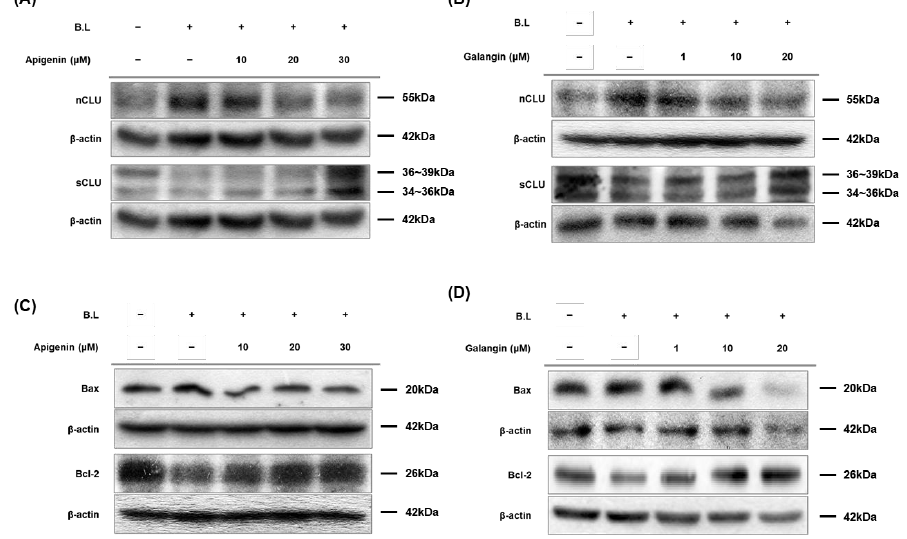
Figure 6. Apigenin and galangin regulated expression of nuclear and secretory clusterin as well as Bax/Bcl-2 ratio in blue light-irradiated HaCaT cells. ( A , B ) Protein levels of nuclear clusterin (nCLU) and secretory clusterin (sCLU) were determined by Western blot analysis. Cells were incubated with apigenin (10, 20, 30 μM) ( A ) or galangin (1, 10, 20 μM) ( B ) for 24 h and were then irradiated with blue light (30 min, 76 W/m 2 ). After 24 h incubation, the cells were subjected to the same process twice and were finally subjected to Western blot analysis. The total proteins were extracted from the cells immediately after experimental conditions, and β -actin was used as a loading control. ( C , D ) Protein levels of Bax, apoptotic protein, and Bcl-2, anti-apoptotic protein, were determined by Western blotting. Cells were incubated with apigenin (10, 20, 30 μM) ( C ) or galangin (1, 10, 20 μM) ( D ) for 24 h and were then irradiated with blue light (30 min, 76 W/m 2 ). After 24 h incubation, the cells were subjected to the same process twice and were finally subjected to Western blot analysis. The total proteins were extracted from the cells immediately after experimental conditions, and β -actin was used as a loading control.